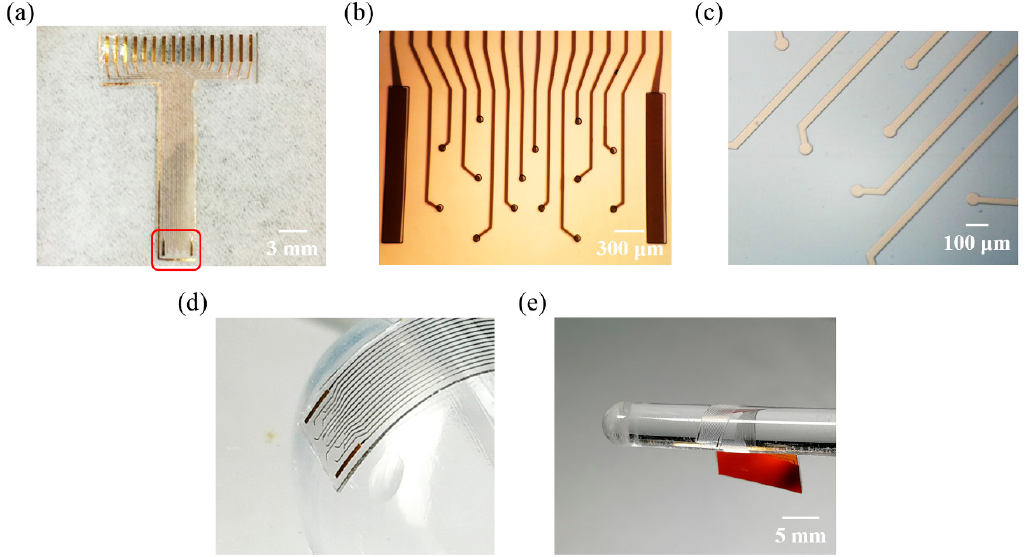
Figure 3. Optical image and the mechanical flexibility of the ECoG electrode array. ( a ) Layout of the electrode; ( b ) Microphotograph of the electrode array; ( c ) Partial enlarged image with clear lines and no cracks; ( d ) The mechanical flexibility was investigated by placing it on a hemisphere ~1.3 cm in diameter; ( e ) Rolling around a cylindrical tube 5 mm in diameter.